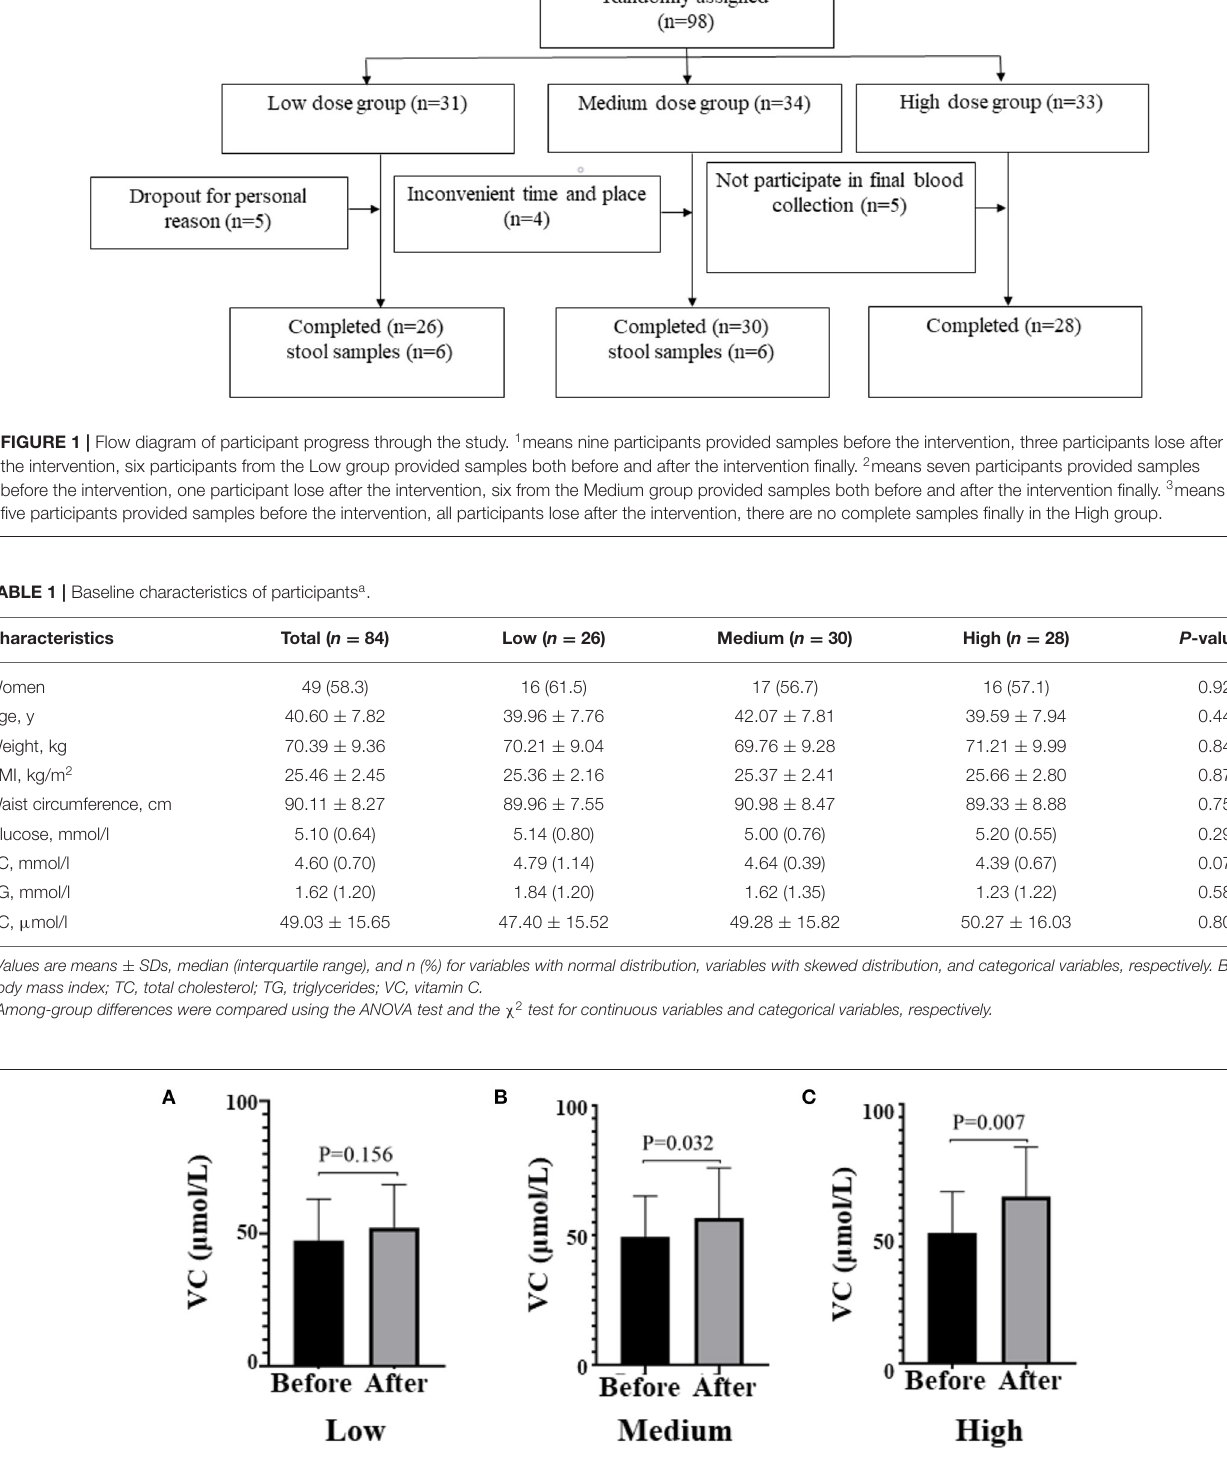
FIGURE 2 | Plasma VC levels before and after the intervention in all three groups, respectively. (A) means Low dose group, (B) means Medium dose group, (C) means High dose group. Black means VC plasma concentration ( µ mol/l) before the intervention, gray means VC plasma concentration after the intervention; paired t -test used to test the difference before and after the intervention in three groups. VC, vitamin